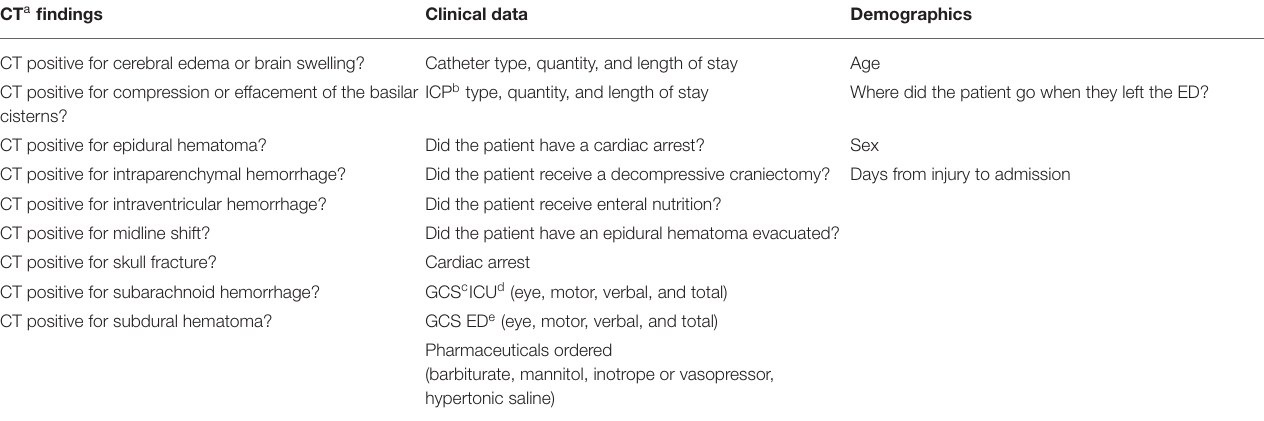
TABLE 1 | Summary of the different types of data and parameters in the Hackathon Pediatric Traumatic Brain Injury (HPTBI)